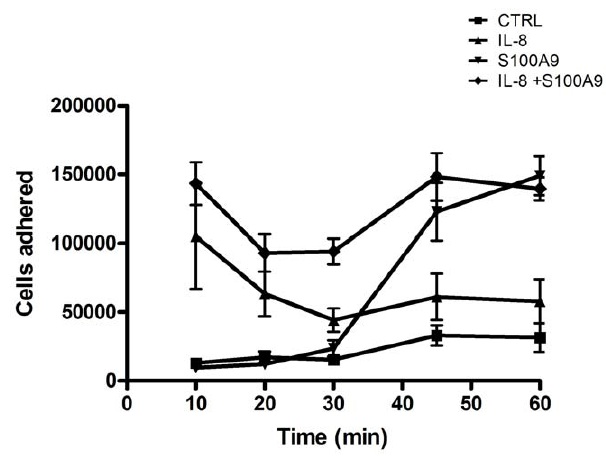
Figure 7. S100A9 increases neutrophil adhesion to fibrinogen. Neutrophils were incubated with S100A9 (40 m g/ml) or IL-8 (5 ng/ml) alone or in combination and allowed to adhere to fibrinogen for different incubation periods at 37 u C. The number of adhered neutrophils was determined as described in Materials and Methods. Data shown represent the mean 6 SEM of at least 3 experiments using